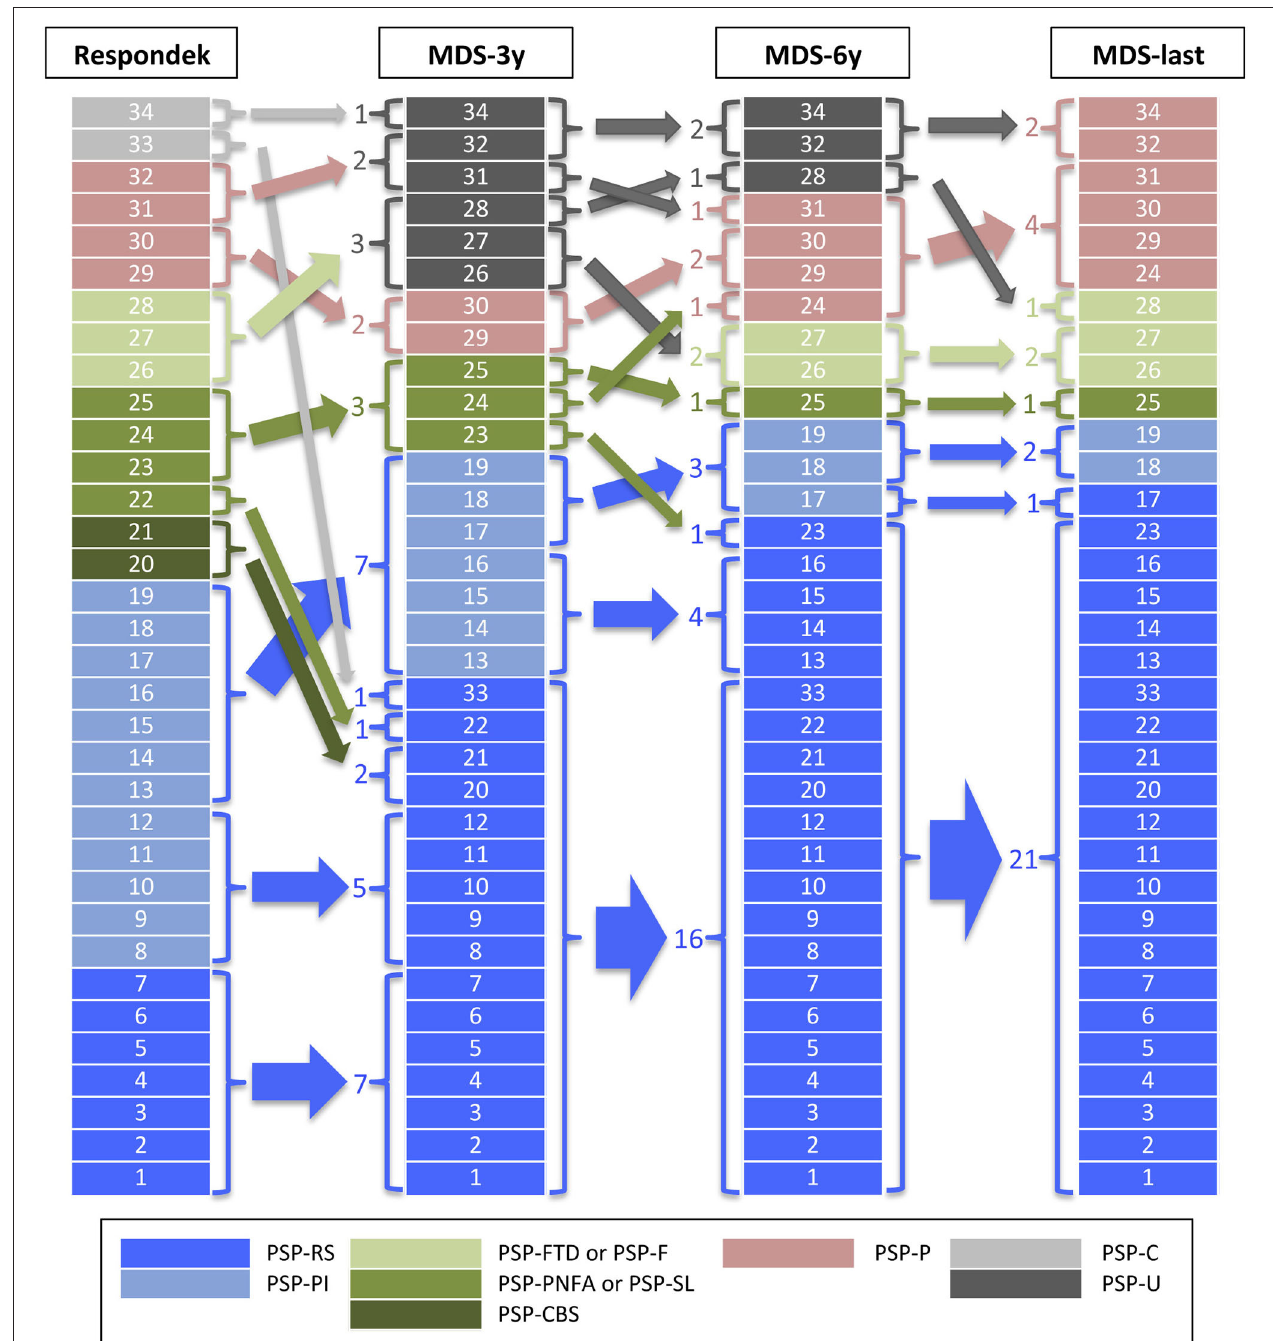
FIGURE 1 | PSP phenotype distribution. The figure shows the PSP phenotype distribution after applying the criteria used by Respondek et al. in (16) (Respondek) or the Movement Disorders Society criteria and MAX rules at 3 years of disease evolution (MDS-3y), at 6 years (MDS-6y) and at last clinical evaluation before to death (MDS-last). PSP-RS, Richardson’s syndrome; PSP-PI, PSP with postural instability; PSP-FTD or PSP-F, PSP with predominant frontal presentation; PSP-PNFA or PSP-SL, PSP with predominant speech/language disorder; PSP-CBS, PSP with corticobasal syndrome; PSP-P, PSP with predominant parkinsonism; PSP-C, PSP with cerebellar presentation; PSP-U, unclassified